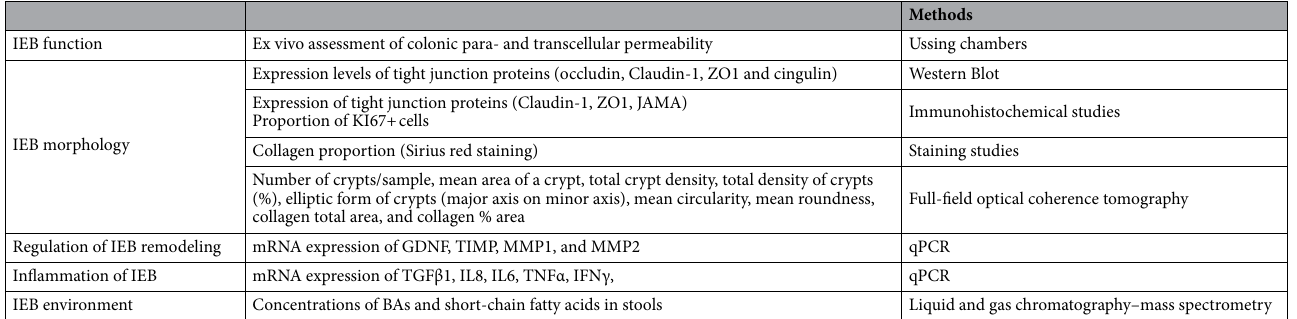
Table 1. Summary of the methods used for the analysis of biopsies and stool samples. IEB intestinal epithelial barrier, qPCR quantitative polymerase chain reaction, BA bile acids, SCFAs short fatt acids.